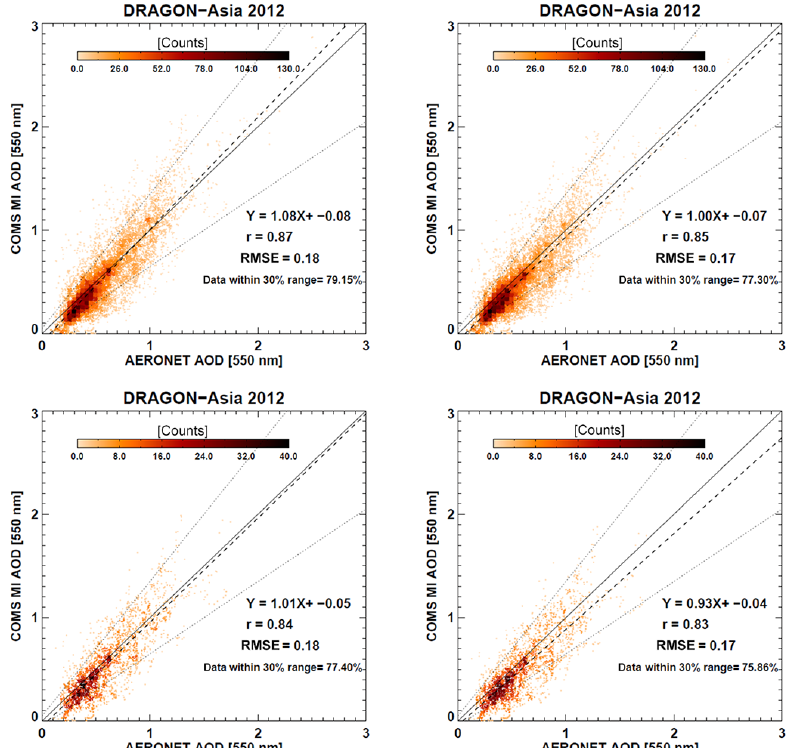
Figure 9. Evaluation of the AOD retrieved from MI measurements during the DRAGON-NE Asia campaign. The x axis and y axis indicate the values of AOD at 550nm obtained from AERONET and MI measurements, respectively, and the color of the symbols shows the data counts for each AOD bin. The y axis on the left (a , c) and right side (b , d) represents the AOD retrieved using the original and new LUT, respectively. The plots at the top (a , b) contain the data measured from all campaign sites, whereas those at the bottom (c , d) contain only the values from the sites excluded from the AOP analysis. The linear regression line with a Pearson coefficient ( r ) and root-mean-square error (RMSE) were included for each